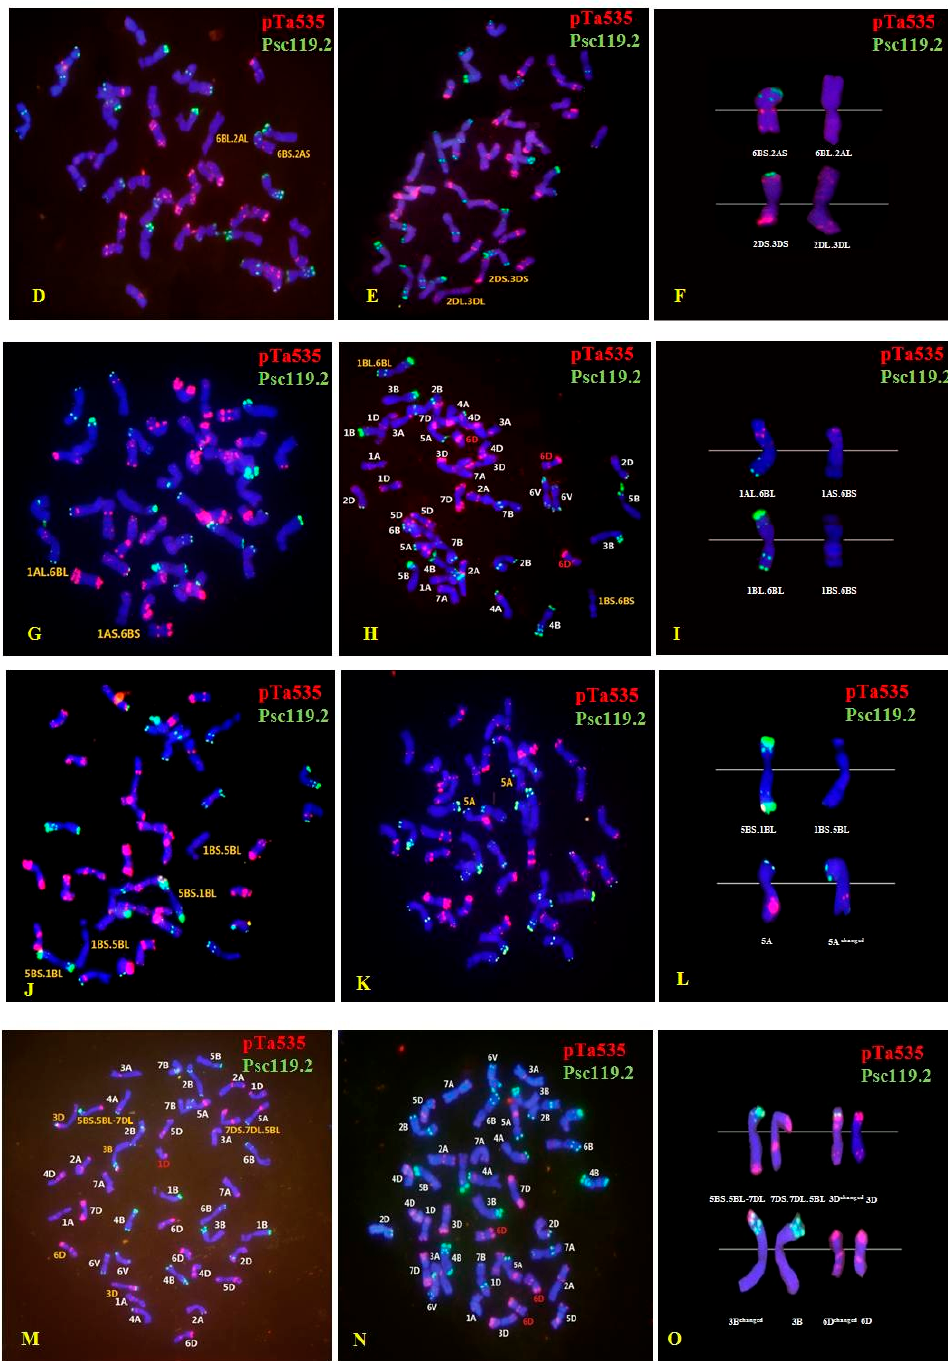
Figure 3. Fluorescence in situ hybridization (FISH) performed usingpTa535 (red) and pSc119.2 (green) as probes for chromosomes with structural changes and mutants in the M 1 generation. ( A , B ) 4B.6V translocation; ( D ) 2A.6B translocation; ( E ) 2D.3D translocation; ( G ) 1A.6B translocation; ( H ) 1B.6B translocation, and 6D trisome; ( J ) 5B.1B translocation; ( K ) 5A aberrations; ( M ) 5B.7D translocation, 3D and 6D aberrations, and 1D monosome; ( N ) 6D trisome. Images ( C , F , I , L , O ) show enlargements of the FISH pattern of chromosomes involved in the structural changes. Chromosomes were counterstained with 4 ′ -6-diamidino-2-phenylindole (blue).